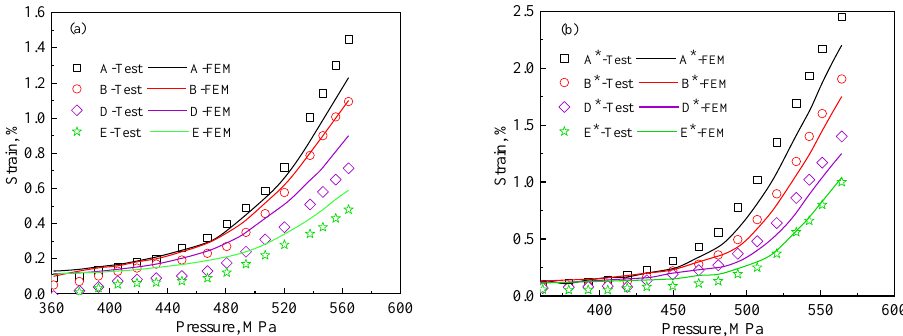
Figure 7. Strain evolution of special points with increasing load in the test: ( a ) region 1# ( b ) region 2#.